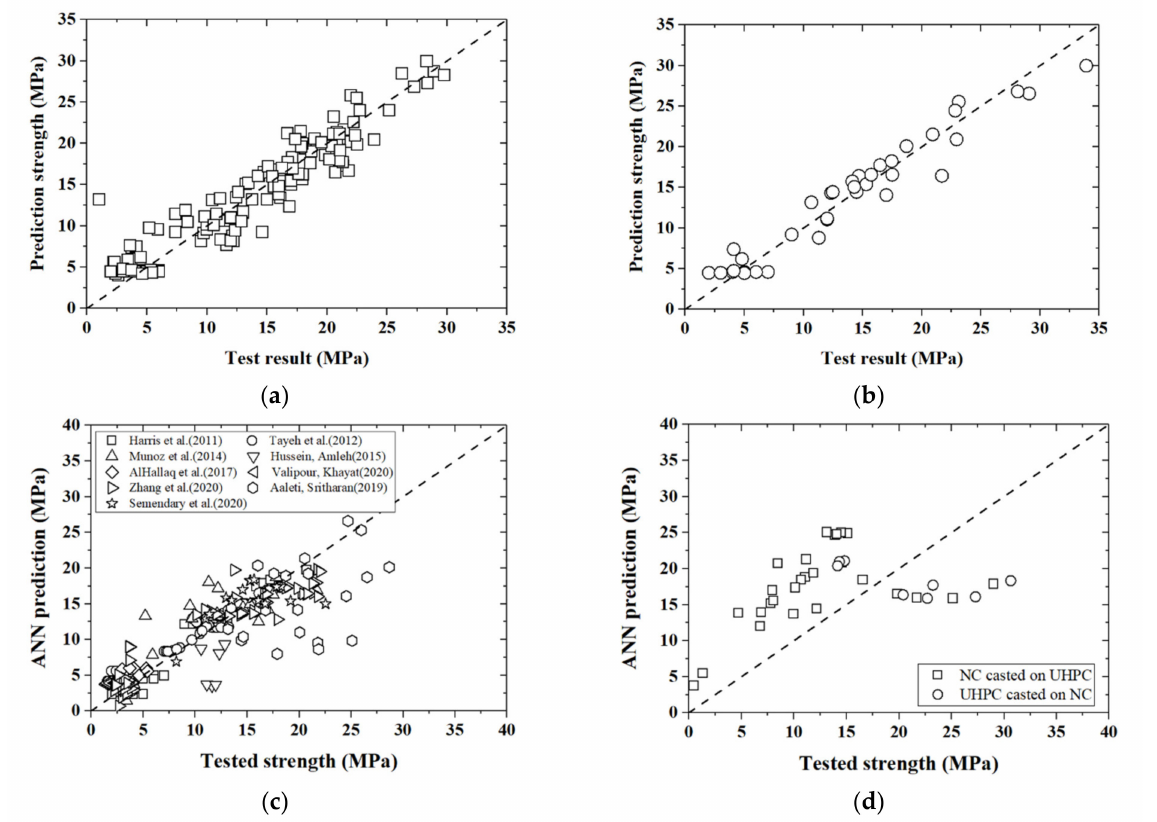
Figure 6. Comparisons between experimental results and ANN predictions. ( a ) Trained group from the database (563 + 338) × 0.8; ( b ) UHPC substrate specimens; ( c ) collected database (563 + 338); ( d ) “improved” slant shear test